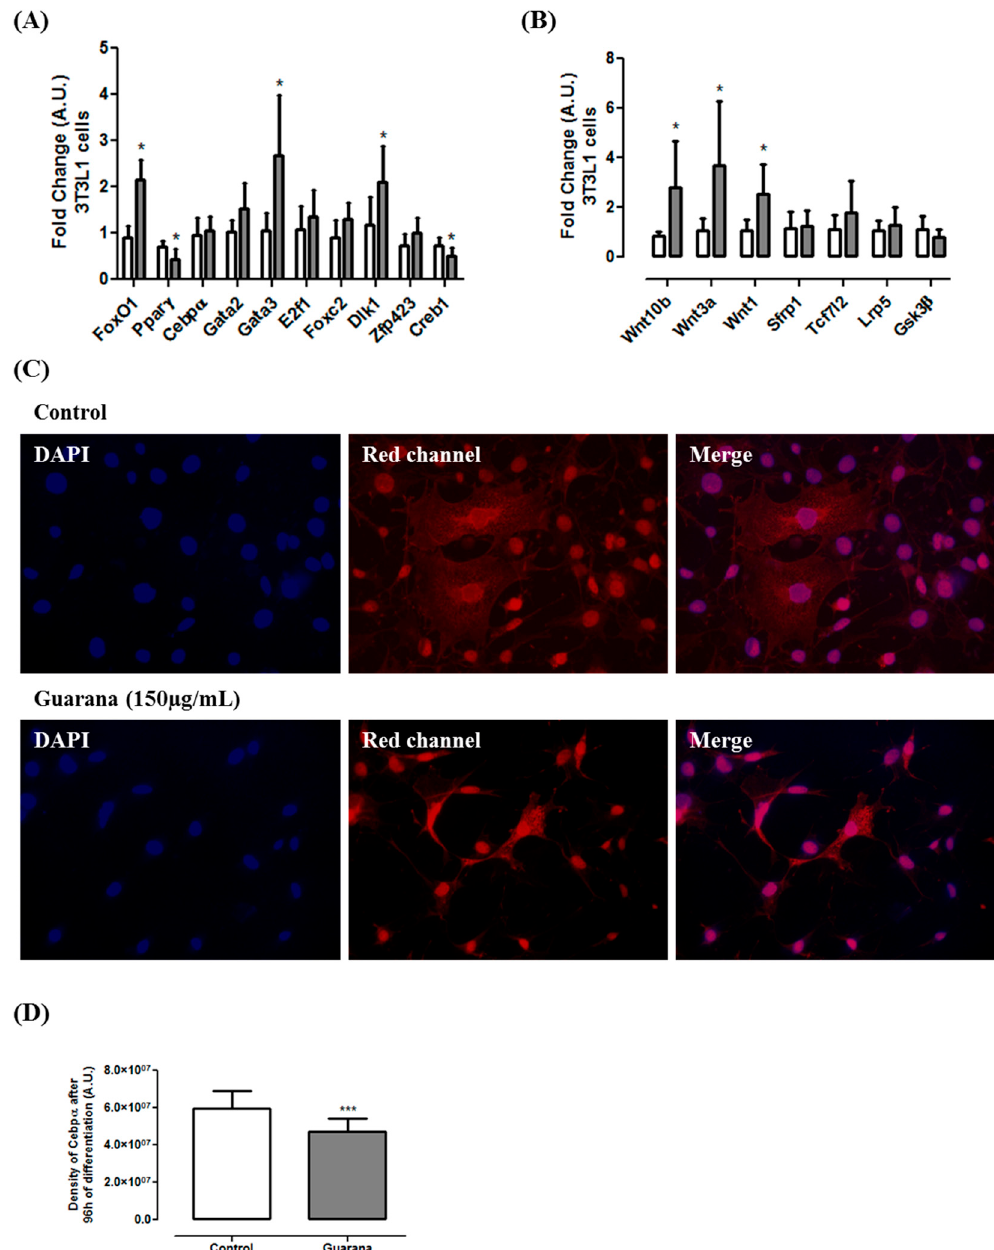
Figure 2. ( A ) Gene expression of FoxO1 , Ppar γ , Cebp α , Gata2 , Gata3 , E2f1 , Foxc2 , Dlk1 , Zfp423 and Creb1 after 96 h of guarana treatment (150 µ g/mL) in 3T3L1 cells; ( B ) Gene expression of Wnt10b , Wnt3a , Wnt1 , Sfrp1 , Tcf7l2 , Lrp5 and Gsk3- β after 96 h of guarana treatment (150 µ g/mL) in 3T3L1 cells. White bars correspond to Control group and grey bars correspond to Guarana group. * Significative down-regulation was considered when the fold change was ≤− 0.5 and significative up-regulation was considered when the fold change was ≥ +2 (* p < 0.05); ( C ) Immunofluorescence of Cebp α after 96 h of incubation with differentiation medium (Control group) and differentiation medium + guarana 150 µ g/mL (Guarana group) in 3T3L1 cells; ( D ) Density of Cebp α after 96 h of incubation with differentiation medium (Control group—white bar) and differentiation medium + guarana 150 µ g/mL in 3T3L1 cells. Density was evaluated using Image J software. *** Guarana group (grey bar) p < 0.0001 compared to Control group (white bar).